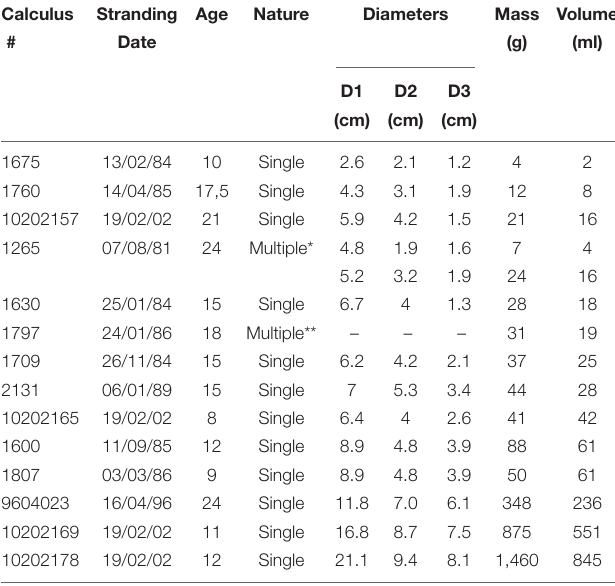
Age Determination